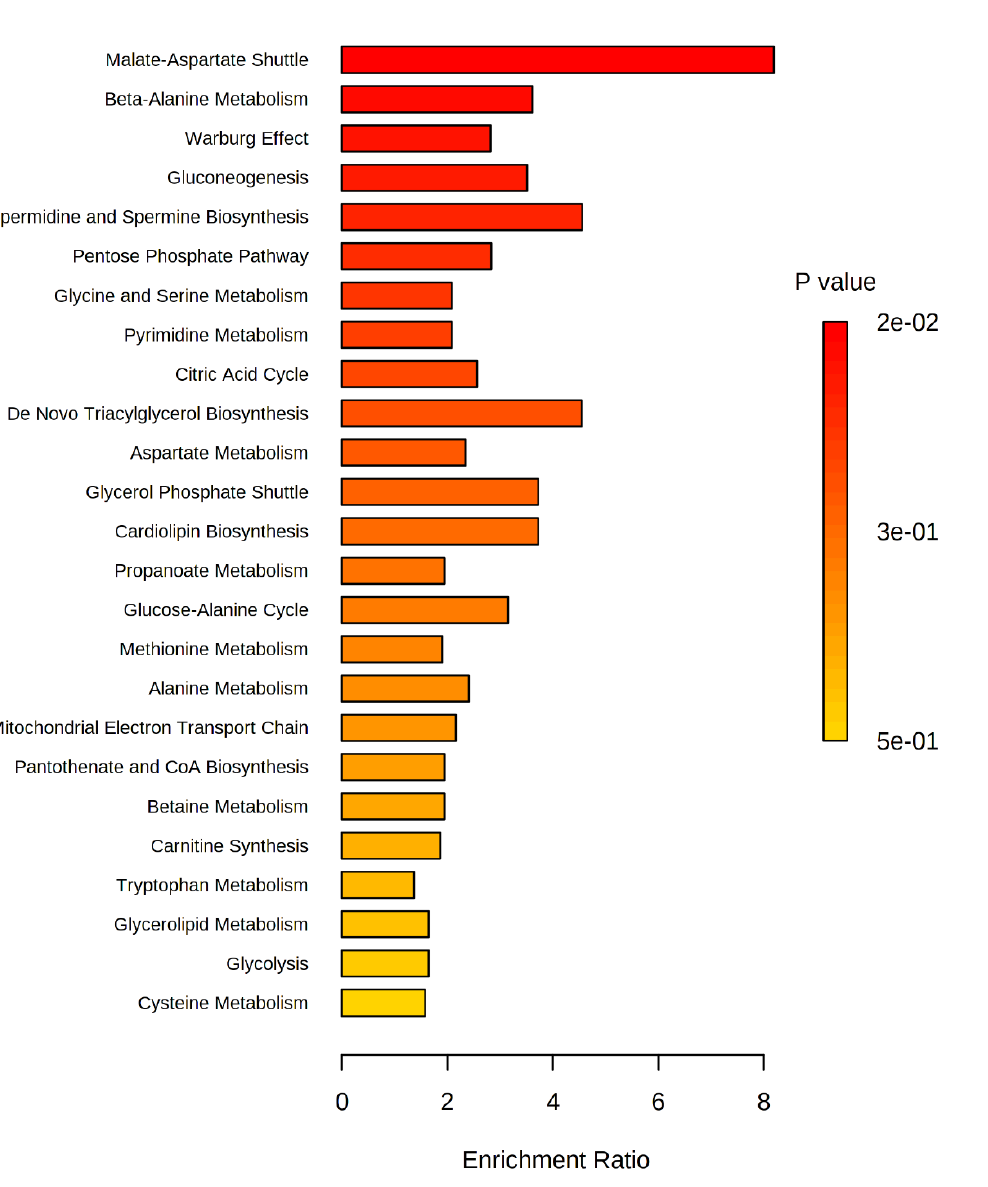
Figure 4. Statistically significant ( p < 0.05) for OSCC.